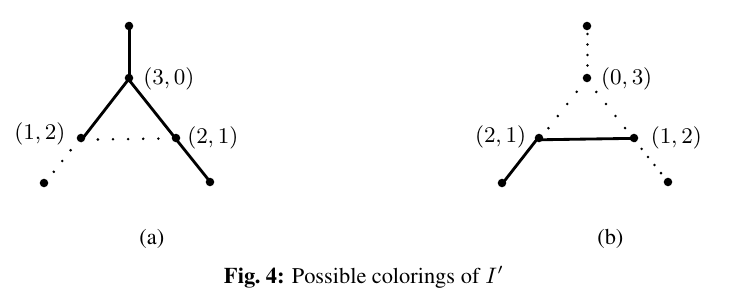
Fig. 5: The graph M